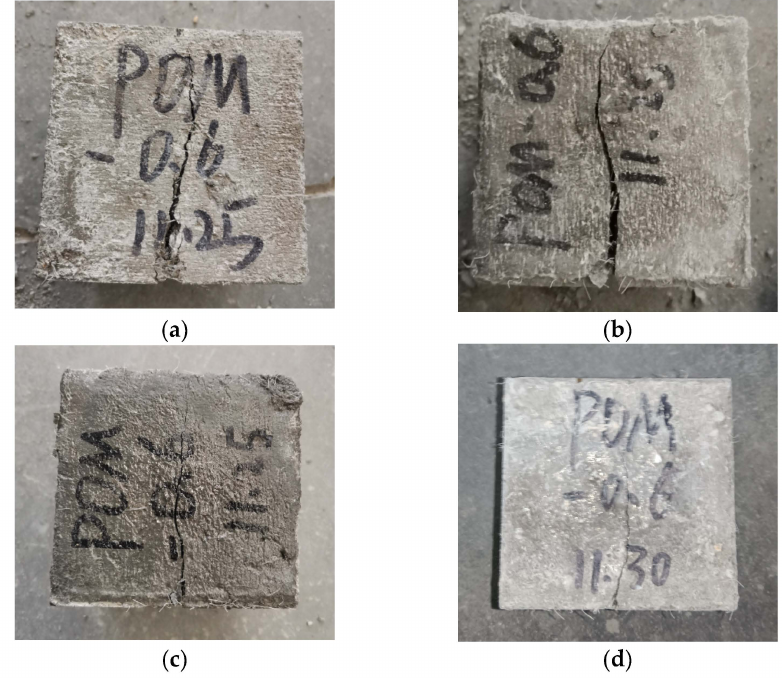
Figure 18. Failure performance of POM0.6 specimens with different ages after splitting tensile test: